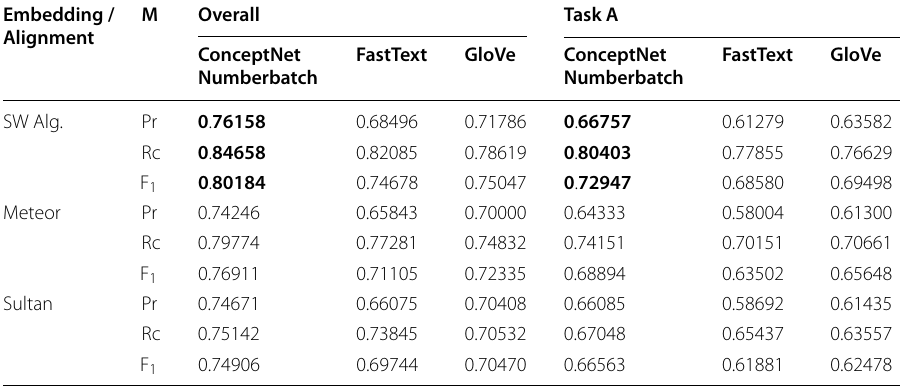
Bold values refer to the highest values of F 1 scores of each task